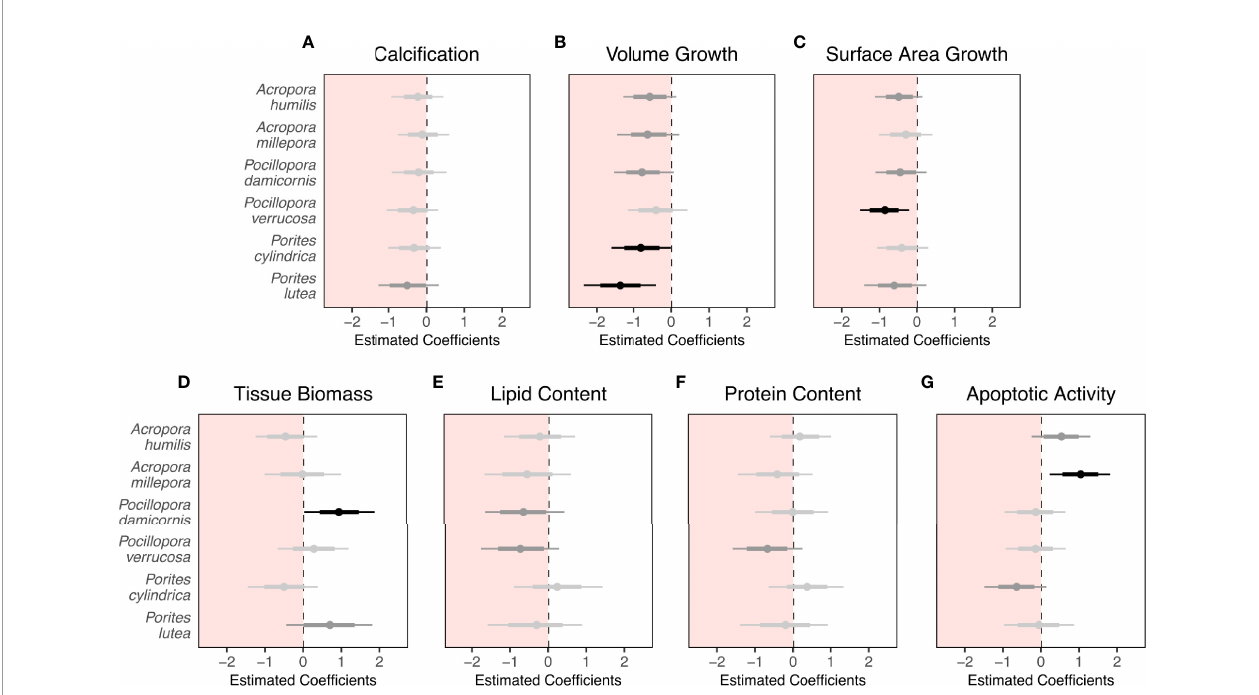
FIGURE 1 | Effect of three-month low pH treatment on (A) calci fi cation, (B) volume growth, (C) surface area growth, (D) tissue biomass, (E) lipid content, (F) protein content, and (G) apoptotic activity of six scleractinian coral species (n = 9 fragments per species per treatment). Points indicate the median of modeled regression coef fi cients of comparisons between treatment groups within a Bayesian framework from a generalized linear latent variable model (GLLVM). Thin and thick lines are 95% and 75% credible intervals (CIs), respectively. Statistically signi fi cant effects (i.e., 95% CIs that do not overlap zero) are colored black, trends (i.e., 75% CIs that do not overlap zero) are colored dark grey, and non-signi fi cant effects are colored light grey. Summarized parameter coef fi cients and CIs extracted from the GLLVM are provided in Supplementary Table S5